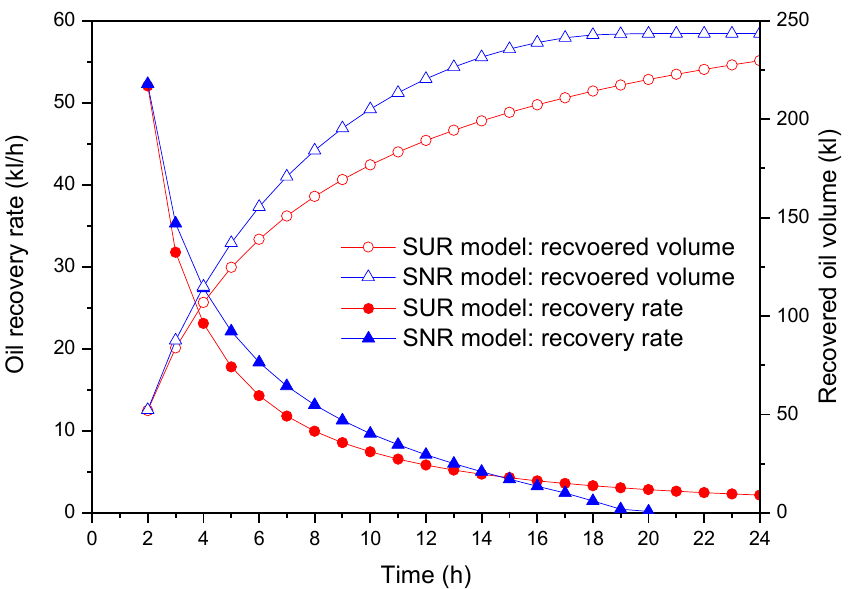
Figure 10. Comparison of mechanical oil recovery rate and cumulative recovery volume between the SUR model and the SNR model.